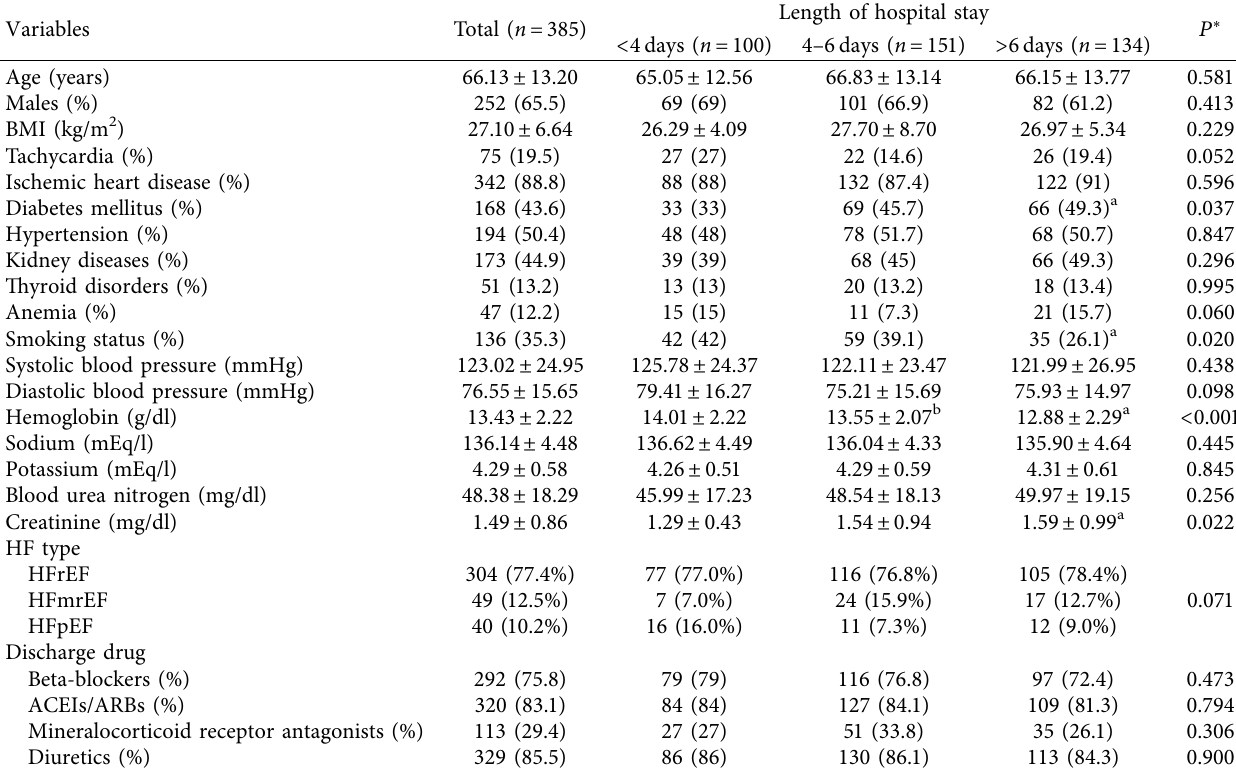
Table 1: General and laboratory characteristics and drug history of the study population according to the length of hospital stay. Variables